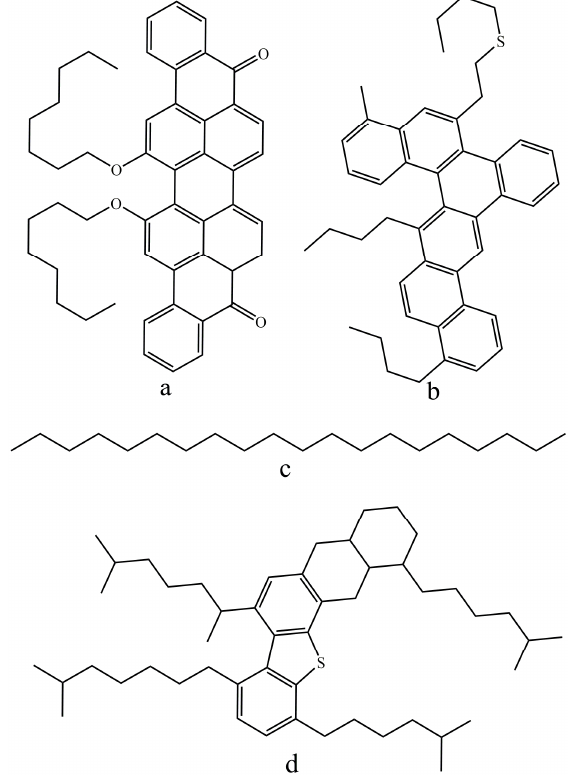
Figure 2. Molecular structures of bitumen component (SARA) fractions: ( a ) asphaltenes (C 50 H 48 O 4 ), ( b ) aromatics (C 46 H 50 S), ( c ) saturates (C 20 H 42 ), and ( d ) resins (C 50 H 80 S).